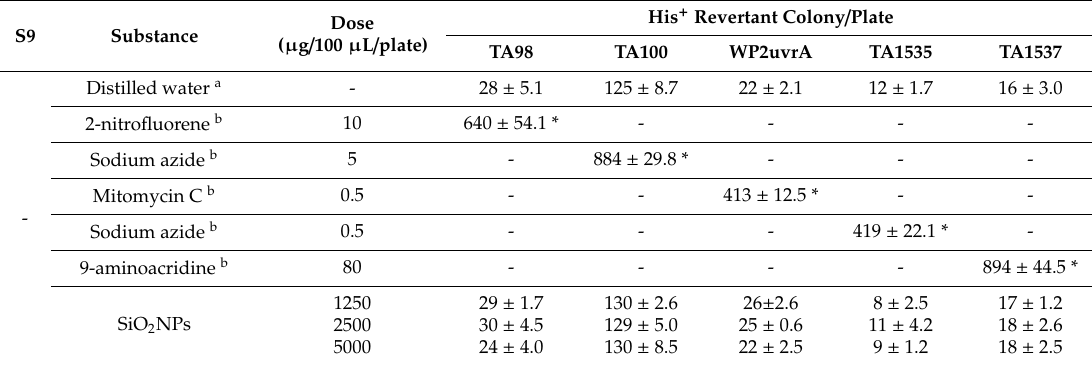
Table 2. Results of S. typhimurium reversion assay with SiO 2